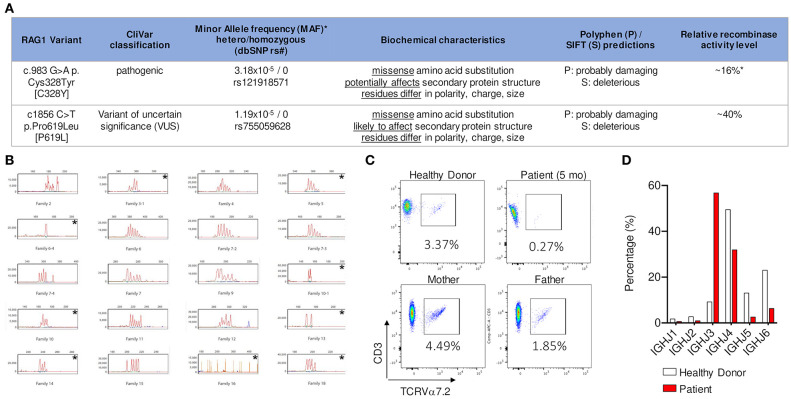
(A) NGS identified two heterozygous missense variants in trans in RAG1. Relative recombination activity level of the two alleles [16% (ref 16) and 40% (novel variant, measured in this study)] predict an overall relative recombinase activity of 28% that is characteristic of CID-G/AI phenotype (*based on gnomAD 12/2019). (B) CD3+ T cells analyzed by spectratyping using 28 probes to measure CDR3 length variability in 23 TCRVβ families and sub-families. Families 2 to 18 are selected for representation. The following families demonstrated an oligoclonal distribution, i.e., <5 peaks: 3–1, 5, 6–4, 10–1, 10, 13, 14, and 18; family 16 had no peak. Each is identified with an * in the upper right corner. (C) Detection of Vα7.2 segment in CD3+ T lymphocytes by flow cytometry shows that the patient had near absence of CD3+T cells expressing the TCR Vα 7.2 chain [encoded by a distal V TCR locus] compared to healthy control and family members (measured in collaboration with the NIH). (D) Frequency of individual IGHJ gene usage of memory B cell receptor repertoire shows decrease in usage of the distal IGHJ5 and IGHJ6 gene elements in patient compared to age matched healthy donor.